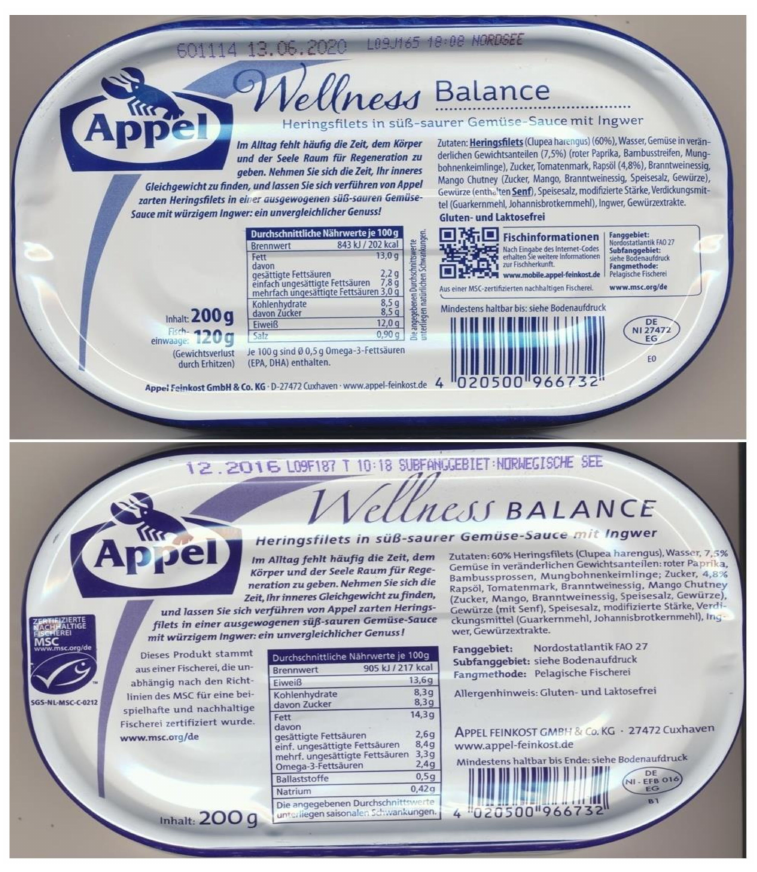
Figure 2. Example of two cans from the same manufacturer containing herring fillet in vegetable sauce derived from the same region (Northern Atlantic). Different amounts of omega-3 FA declared on the reverse side of the cans: 0.5 g/100 g ( above ) and 2.4 g/100 g ( below )—presumably harvested and produced in different seasons (dates of fishing were uncertain), compare Table 1; random purchases in a German supermarket—from the years 2017 and 2019,